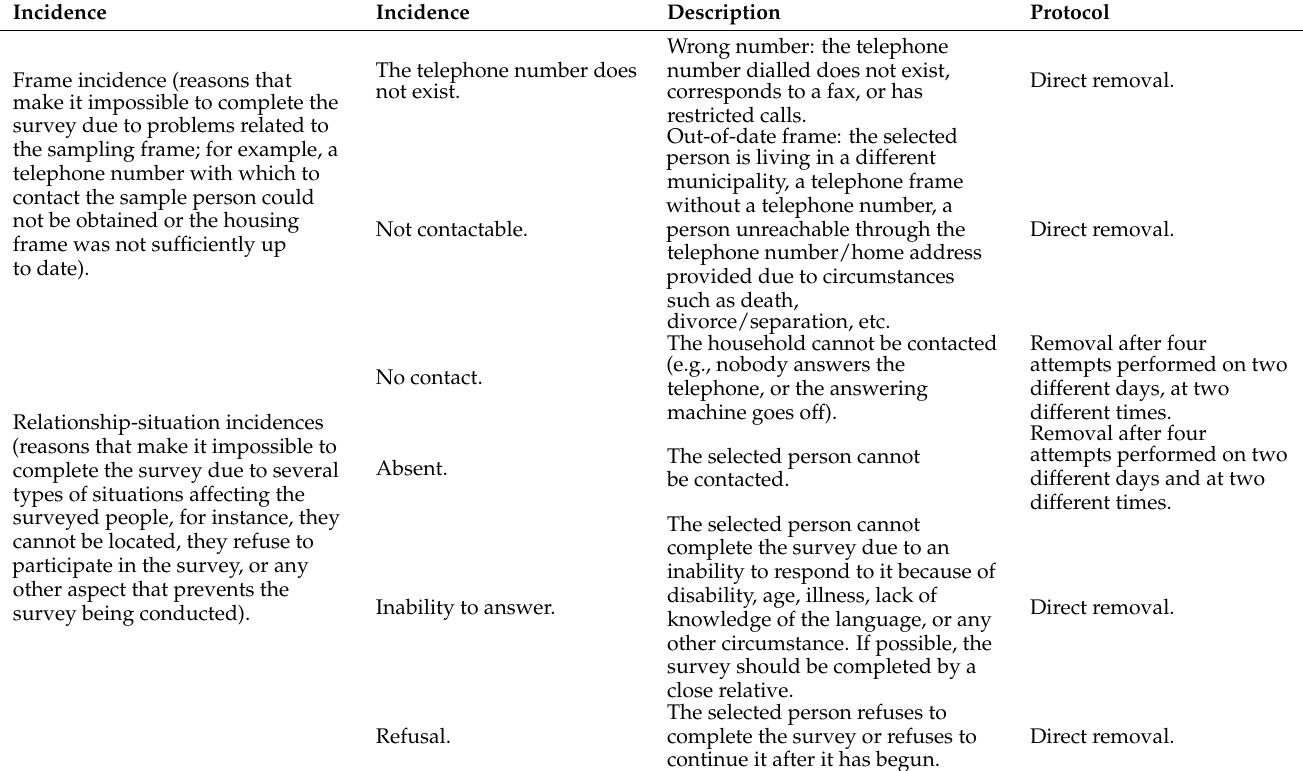
Table 2. Health Care and Social Survey (ESSOC): Interview incidences and protocol to be followed: Incidence Incidence Description